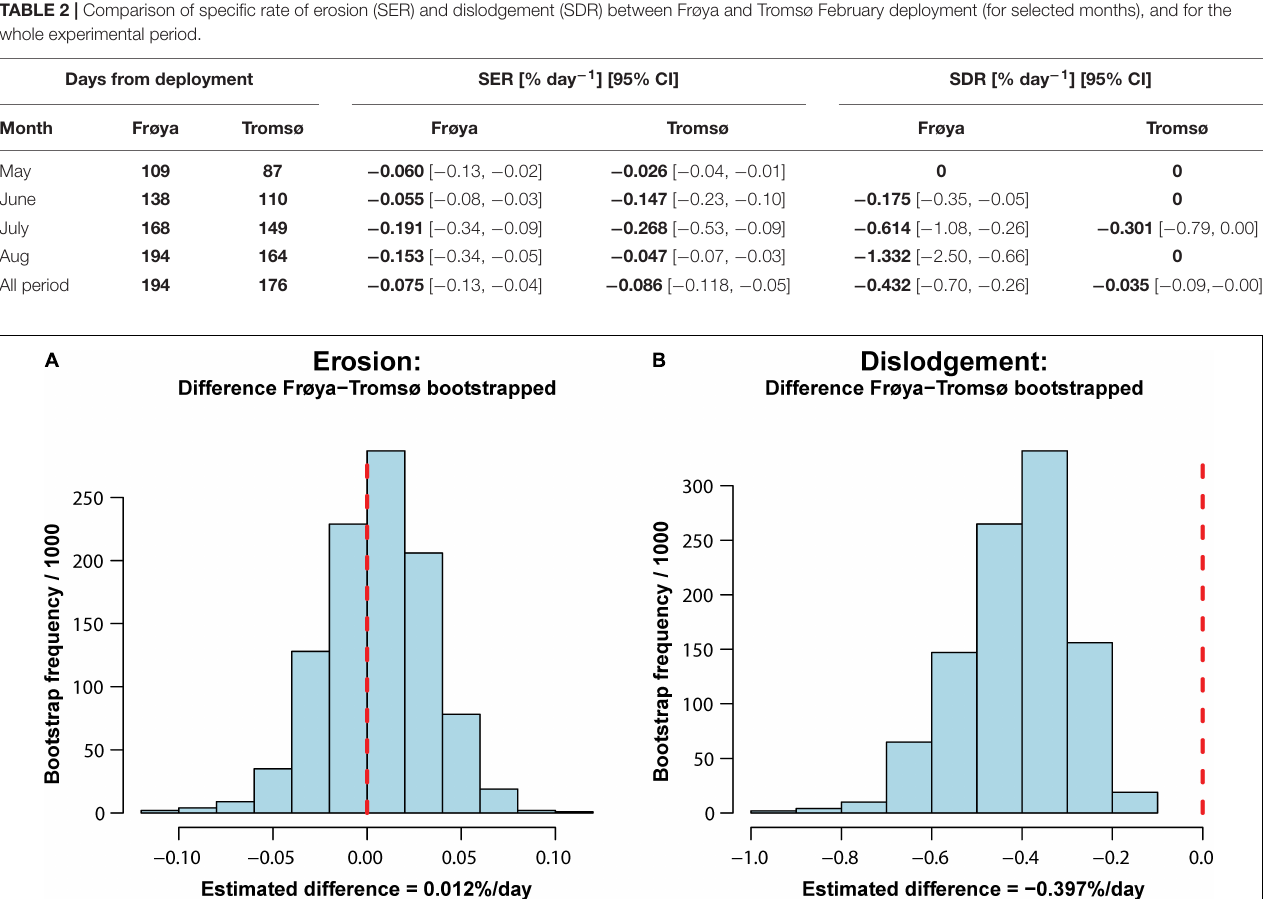
FIGURE 6 | Histograms showing outcome from bootstrap tests of difference in erosion (A) and dislodgement (B) over the whole experimental period. The vertical dashed line shows the null hypothesis of no difference.